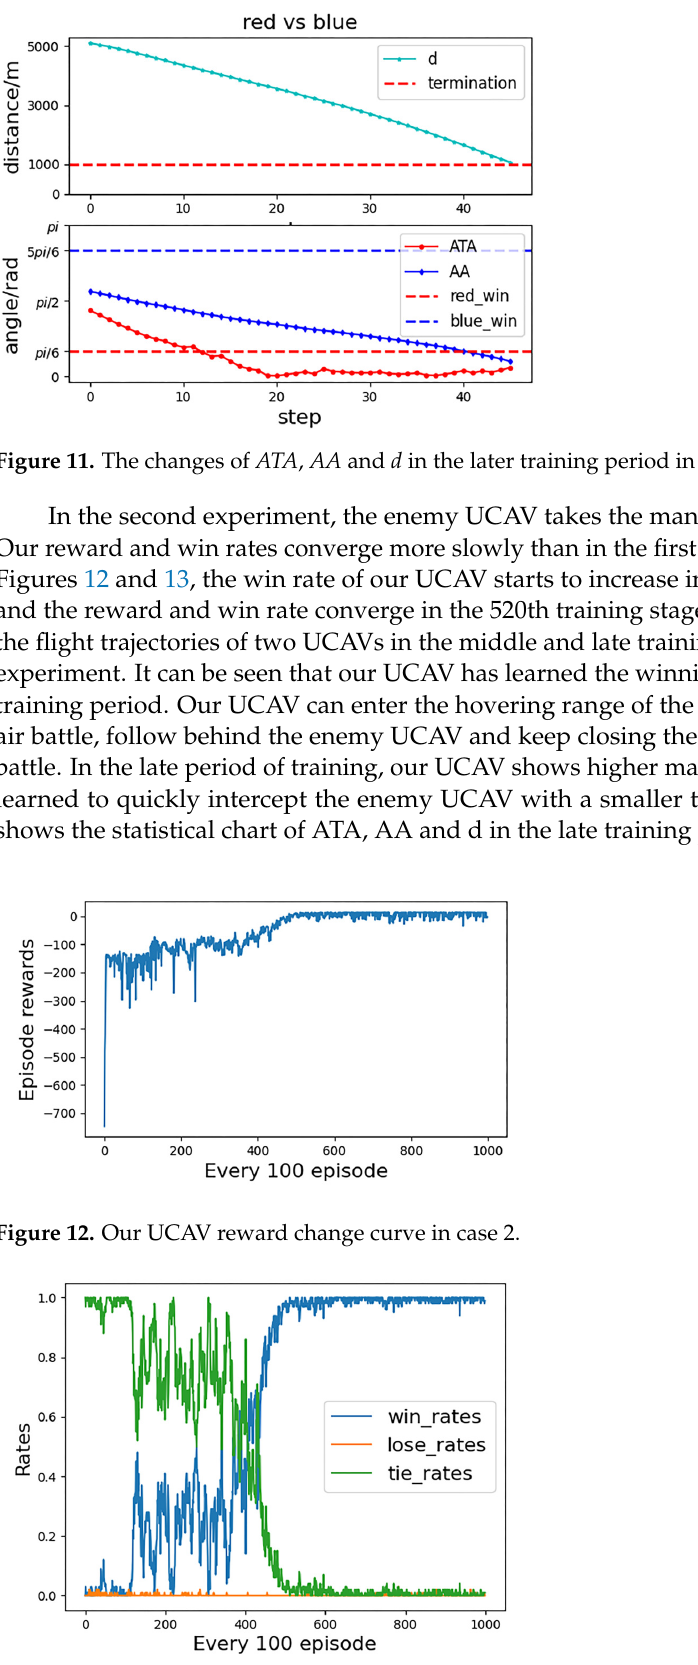
Figure 13. Our UCAV win rate change curve in case